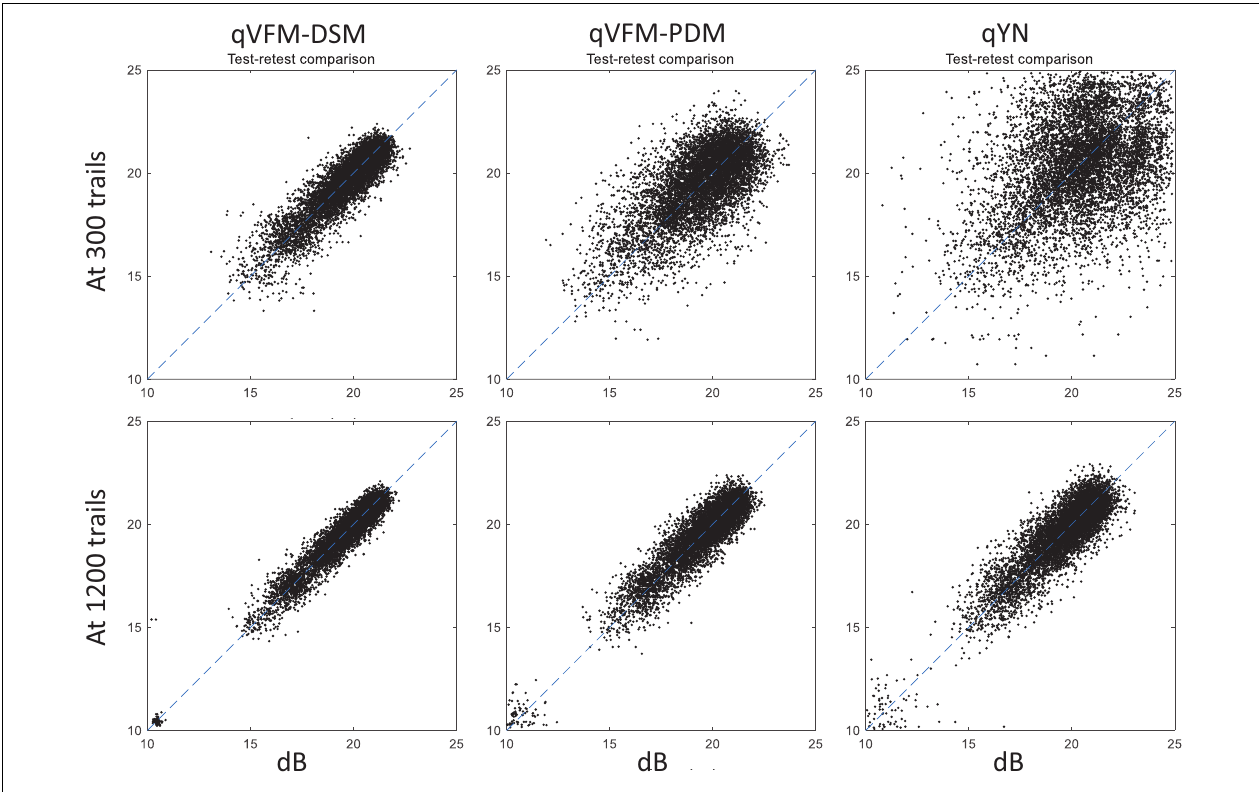
FIGURE 13 | Performance II of the qVFM-DSM, qVFM-PDM and qYN methods in estimating VFM of the simulated cataract observer. Test-retest comparison of the estimated light sensitivities from repeated 200 runs at 300 and 1,200